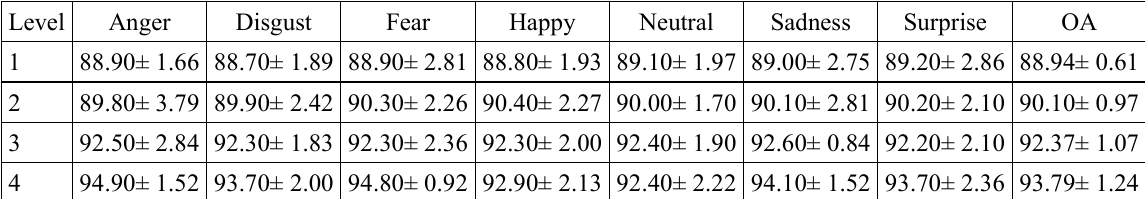
Table 7. Select optimal decomposition